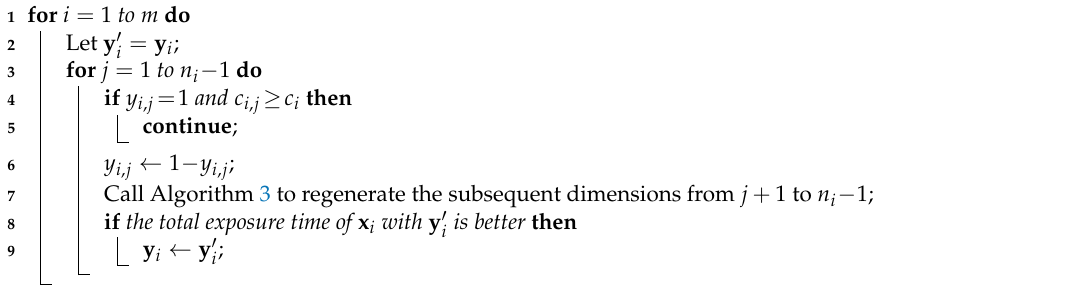
Algorithm 5: The gradual neighborhood search method for improving the direction vector of a